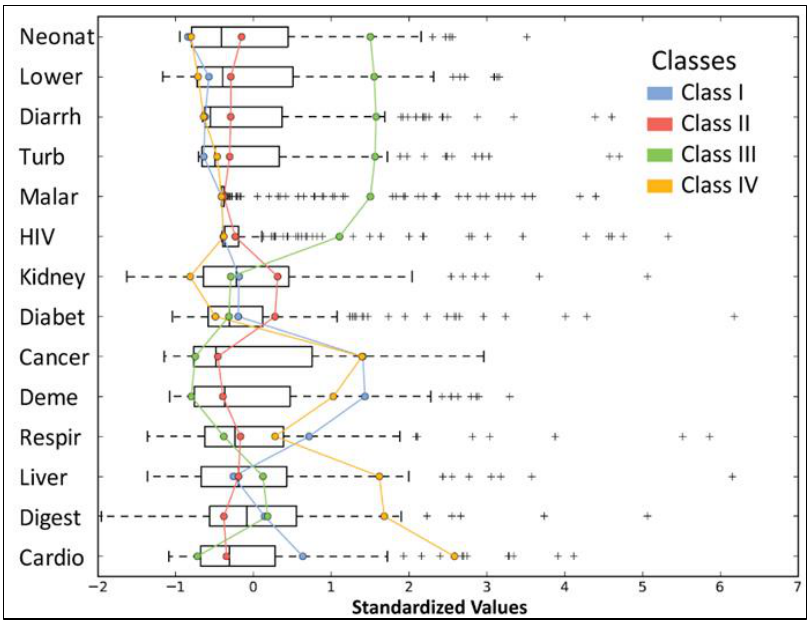
Figure 5. Standardized values by the grouping analysis methods. Source of data: The Institute for Health Metrics and Evaluation, World Bank.